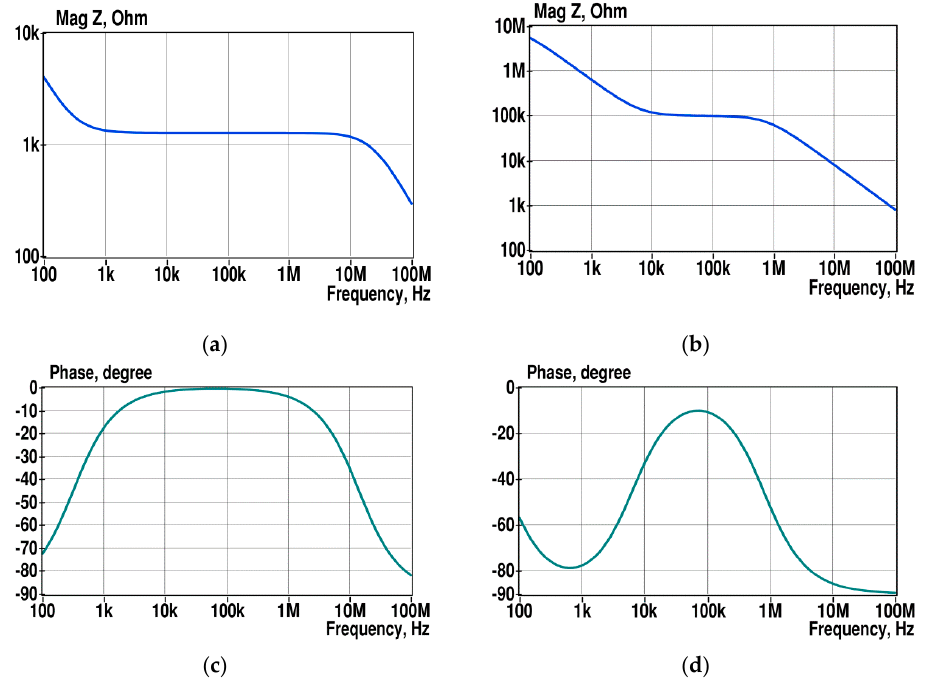
Figure 2. Typical spectra of the saline solution with a conductivity of 1 S/m with the following measurement cell parameters: A = 0.8 mm 2 , l = 1mm ( a , c ), and A = 0.0005 mm 2 , l 2 = 0.05 mm ( b , d ). Double layer capacitances C dl1 = 400 nF, C dl2 = 250 pF, and the capacitances of the solution C s1 = 13.8 pF, C s2 = 0.009 pF. The resistances of the solution R s1 = 1.25 k Ω , R s2 = 100 k Ω , and the stray capacitance C st1 = C st2 = 2 pF.